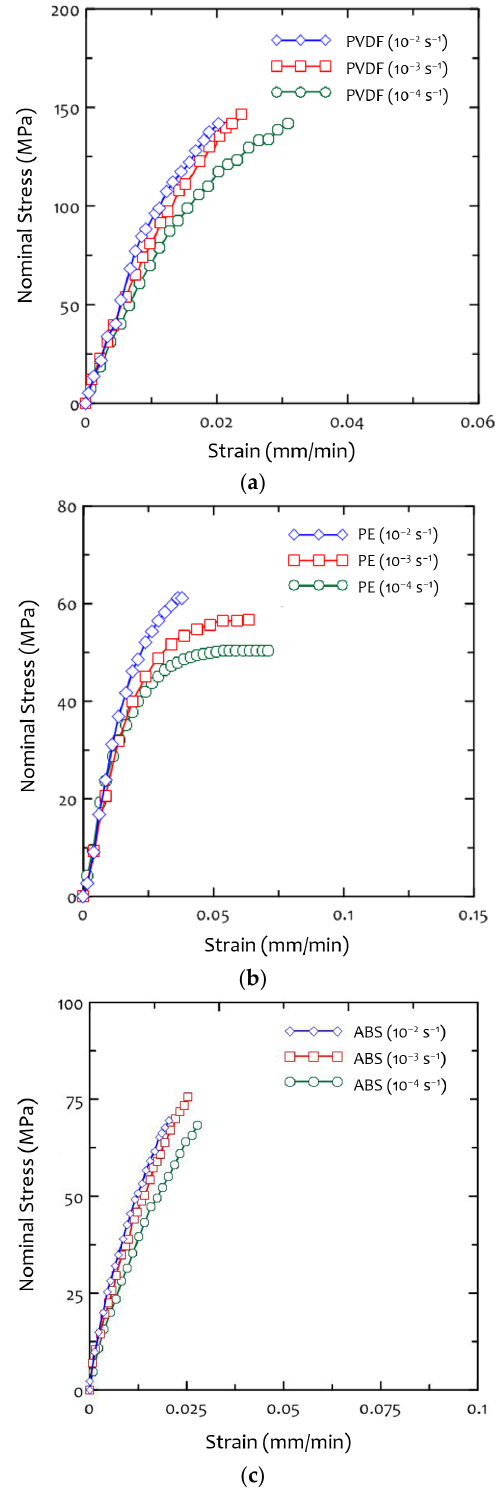
Figure 8. Strain-rate-dependent stress-strain curves of the polymers at − 100 °C: ( a ) PVDF, ( b ) PE, and ( c ) ABS.